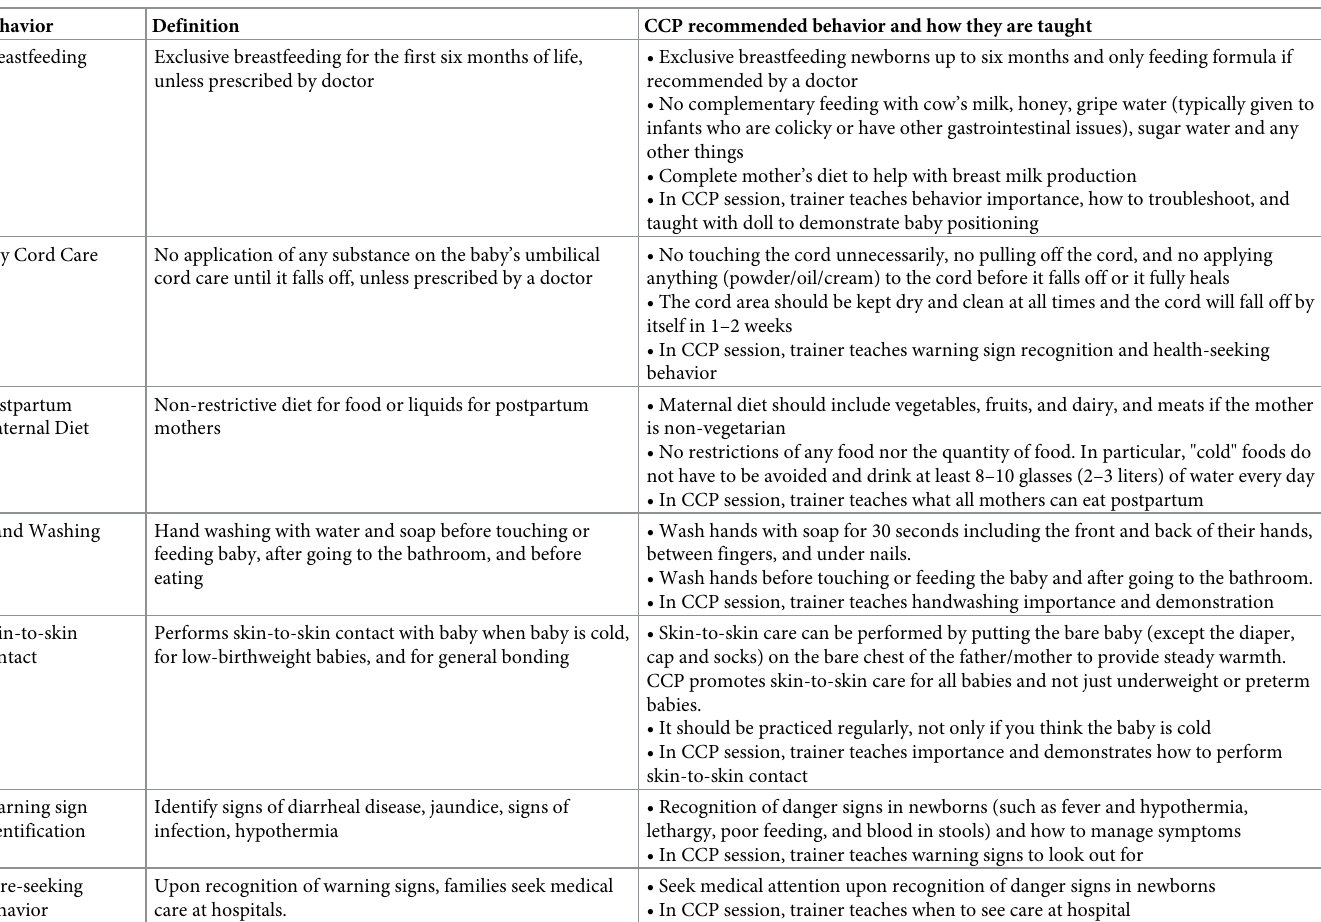
Table 1. Key behaviors definitions and corresponding information taught in CCP